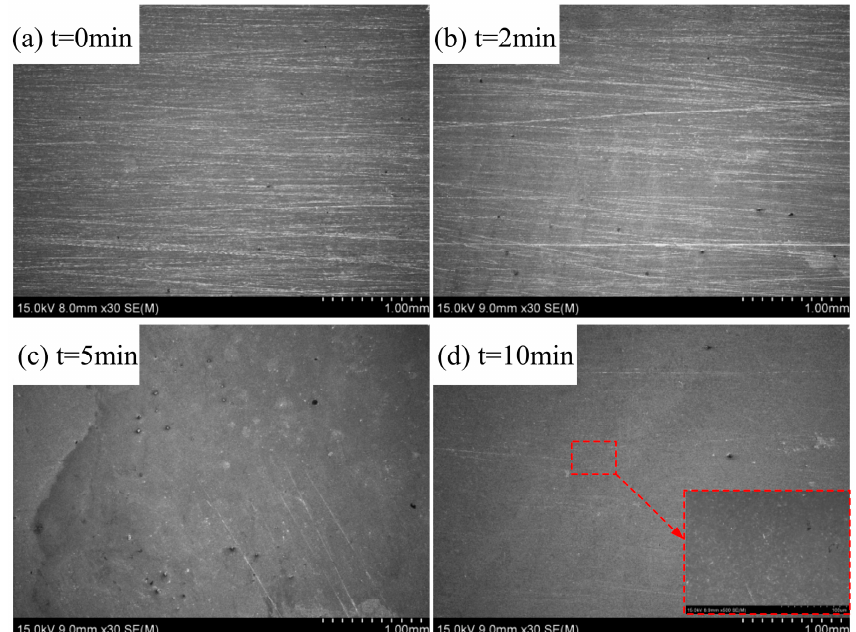
Figure 12. Material removal mechanism of ECFAP in region I (U = 3 V). ( a ) t = 0 min; ( b ) t = 2 min; ( c ) t = 5 min; ( d ) t = 10 min.